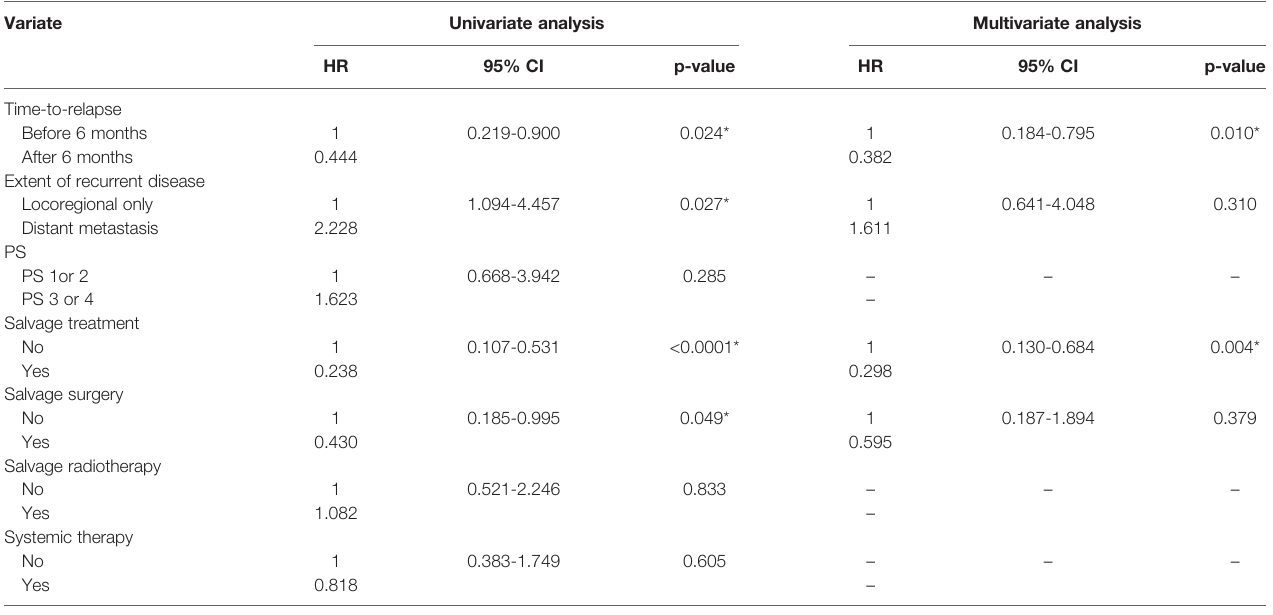
TABLE 5 | Univariate and multivariate analysis for OS after the detection of recurrence.